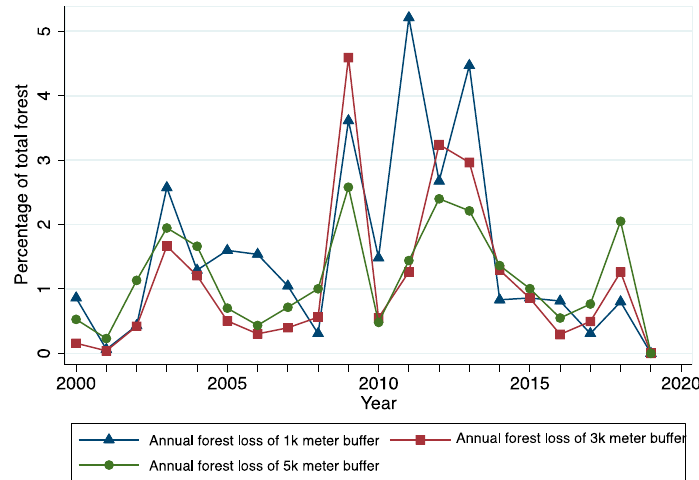
Figure 11. Yearly deforestation rate for Village C in 1000-, 3000-, and 5000-m buffers, 2000–2019 .